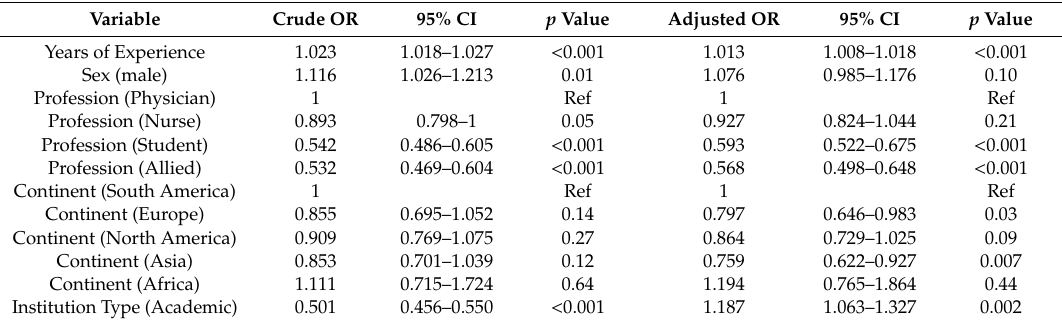
Table 1. Factors associated with reporting previous formal training in a multivariable logistic regression